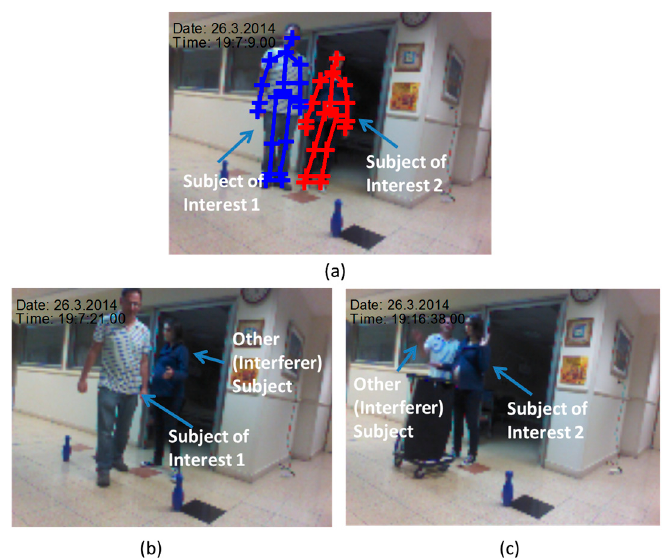
Figure 2. Second and third experiments’ sets: ( a ) Calibration; ( b ) tracking; and ( c ) tapping tracking. In the calibration phase, the two subjects were identified by the Kinect, their features were calculated, averaged, and stored, and formed the KS. The SoI (subject of interest) for the first experiment was the left subject, and for the second, the right subject. For the tracking, the two subjects moved along and out of the range of the Kinect.